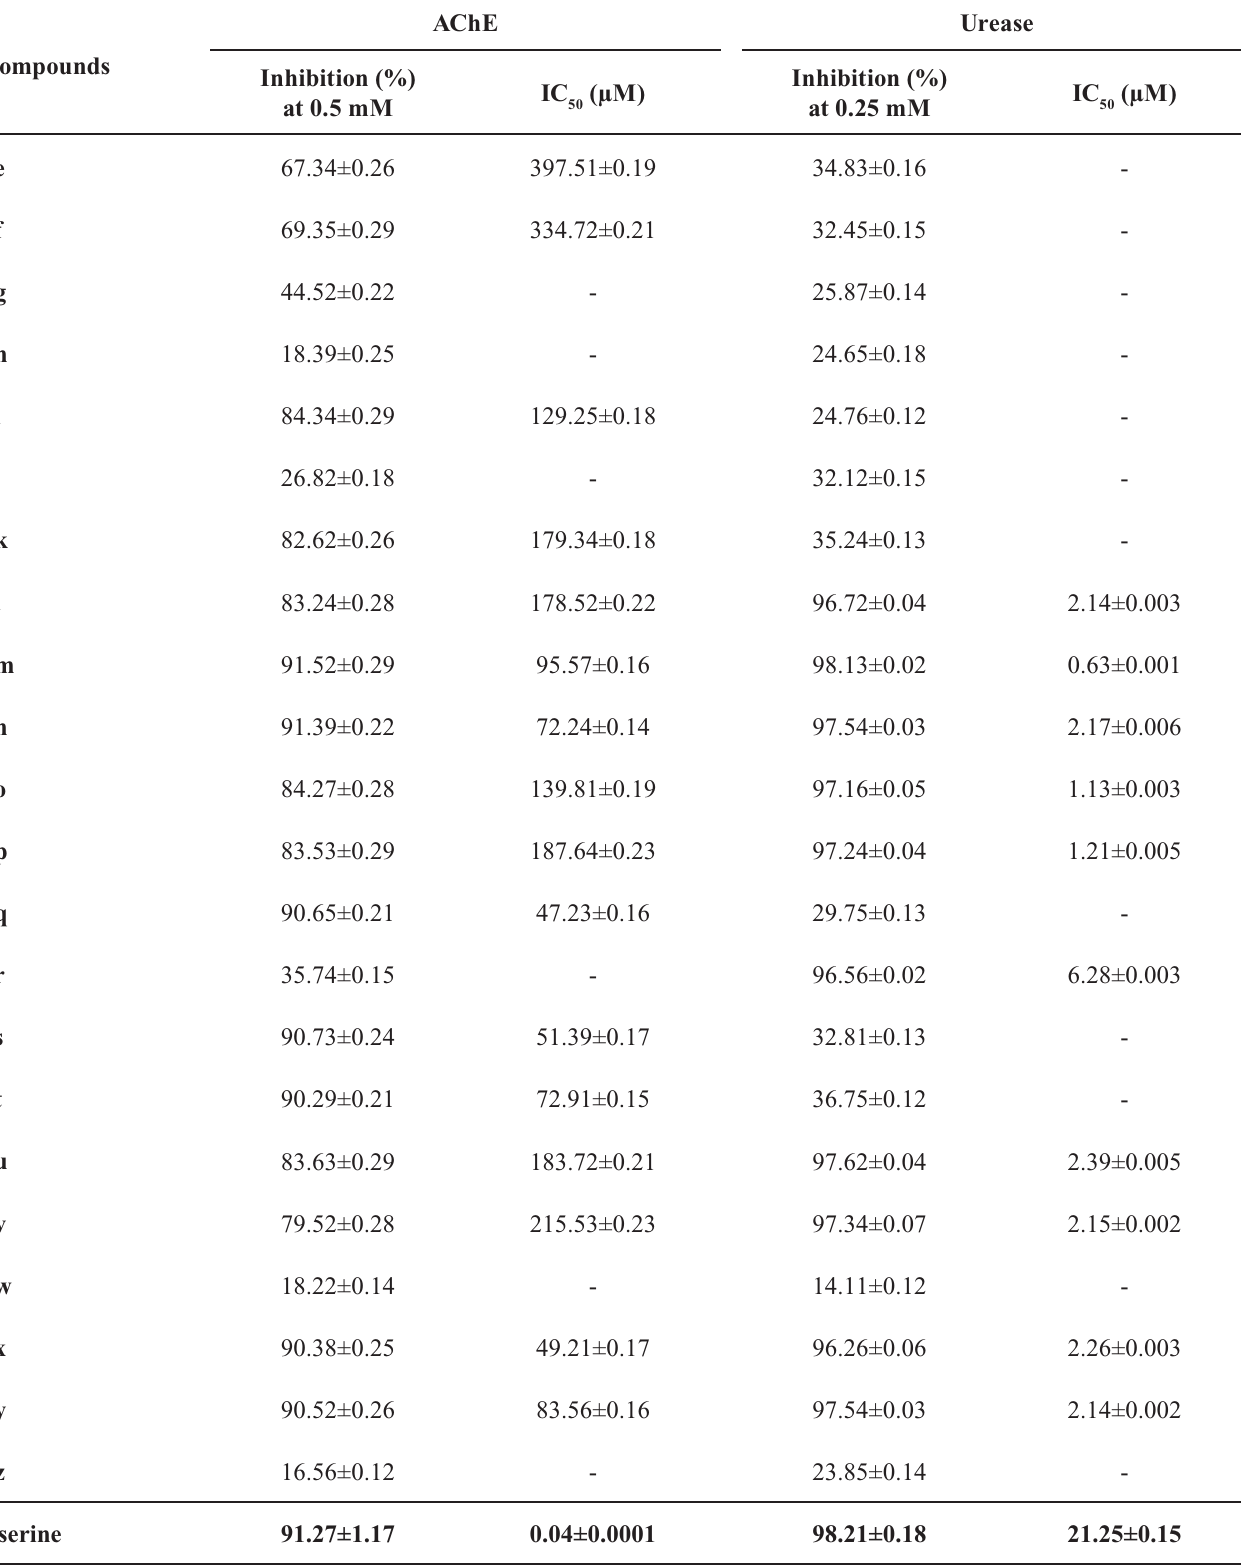
TABLE IV - Acetyl cholinesterase (AChE) and Urease inhibition studies